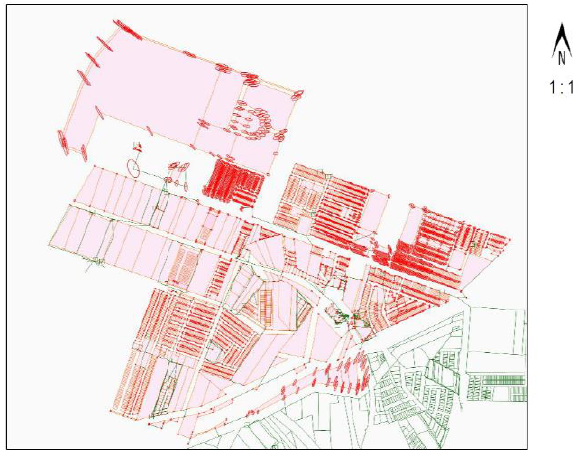
Figure 7. Enlarged Error Ellipses with Filter